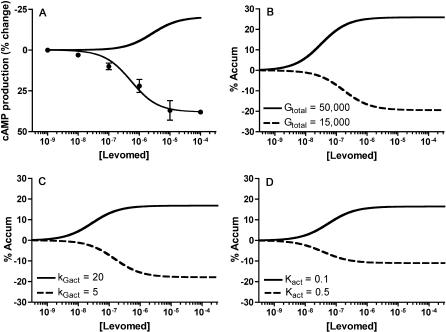
Protean Agonism in the α2A-Adrenergic System(A) Effect of levomed on cAMP production. Note that the y-axis in this plot is inverted from the usual to show positive agonists to have a positive slope and inverse agonists to have a negative slope. Levomed acts as an inverse agonist in HEL 92.1.7 cells (•, with curve fit). Data taken from Jansson et al. (1998), Figure 4. Levomed acts as a positive agonist in PC12 cells (line only). Data reconstructed from EC50 and max percent inhibition reported in Jansson et al. (1994), Table 1.(B–D) Simulations of protean agonism of levomed at the α2A-adrenergic receptor. Small changes in parameter values can cause the response to switch from positive to negative.(B) 3.3-Fold variation in G protein expression, β = 10.(C) A 4-fold variation in the G protein activation rate constant kGact, Gtotal = 100,000.(D) The equilibrium ratio of active to inactive receptors is varied 5-fold, Gtotal = 10,000, kGact = 5 s−1. Parameter values are equal to those listed in Figure 5 except when otherwise noted. Rtotal = 3,500 number/cell. Simulated dose response curves (B–D) measuring the percent accumulation of GαGTP (%Accum) were calculated according to Equation 2 as described in Methods.